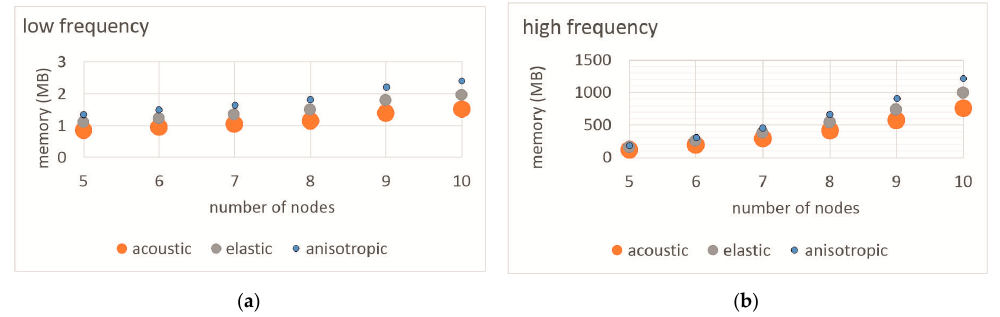
Figure 11. The relationships between the memory workout and the number of nodes per wavelength for: low ( a ) and high ( b ) frequencies of the source wavelet.